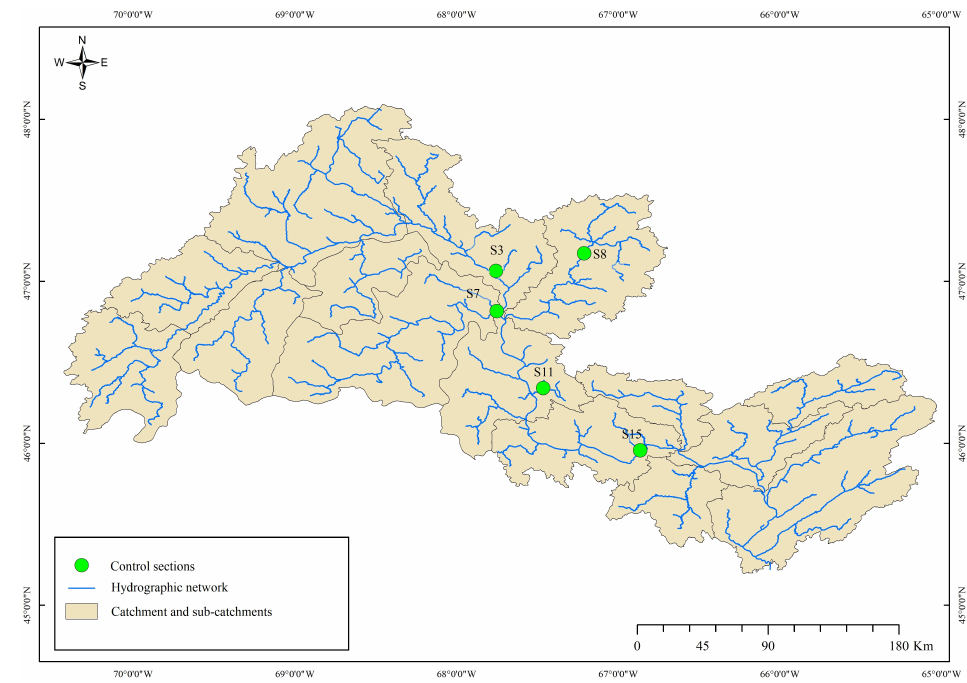
Figure 3. Location of the control sections used to illustrate the Vine-copula approach. Table 2. Marginal distributions and results of the independence